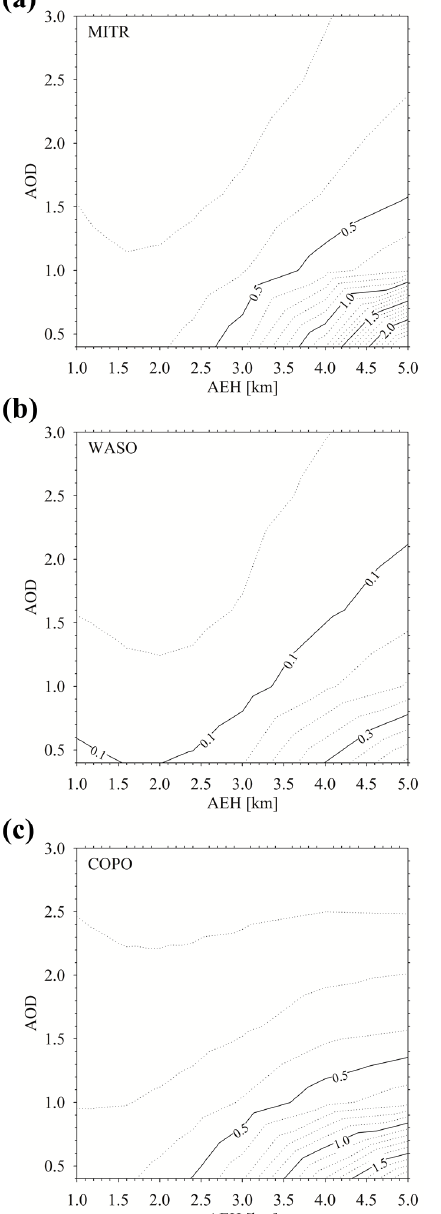
Figure 10. Same as Fig. 7 except for particle size difference of 20%.